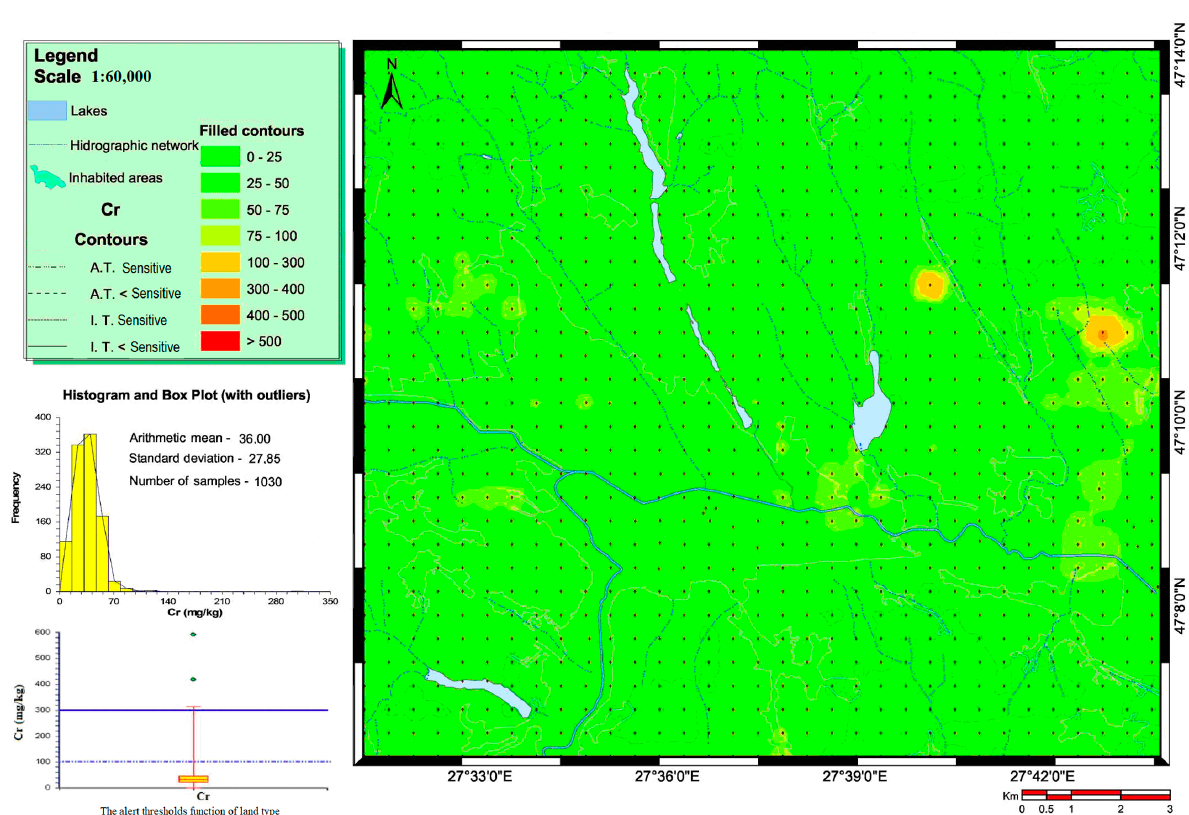
Water 2023 , 15 , x FOR PEER REVIEW Figure 2. Map of Cr distribution in the analysed soil (mg kg − 1 ). Figure 2. Map of Cr distribution in the analysed soil (mg kg − 1 ).